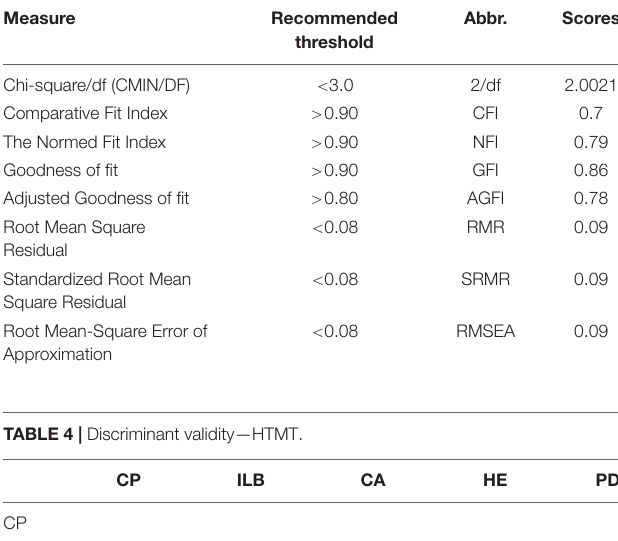
TABLE 3 | CFA model.